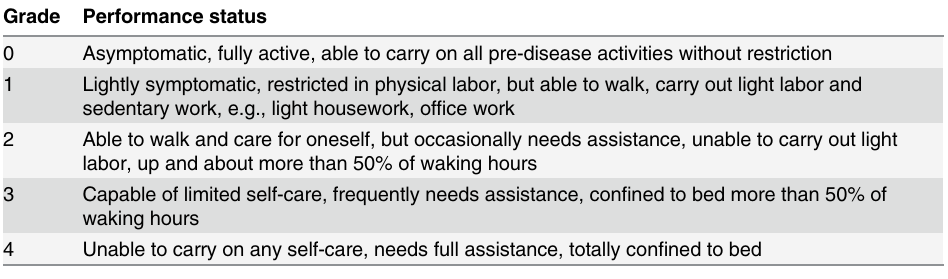
Table 1. Eastern Cooperative Oncology Group performance